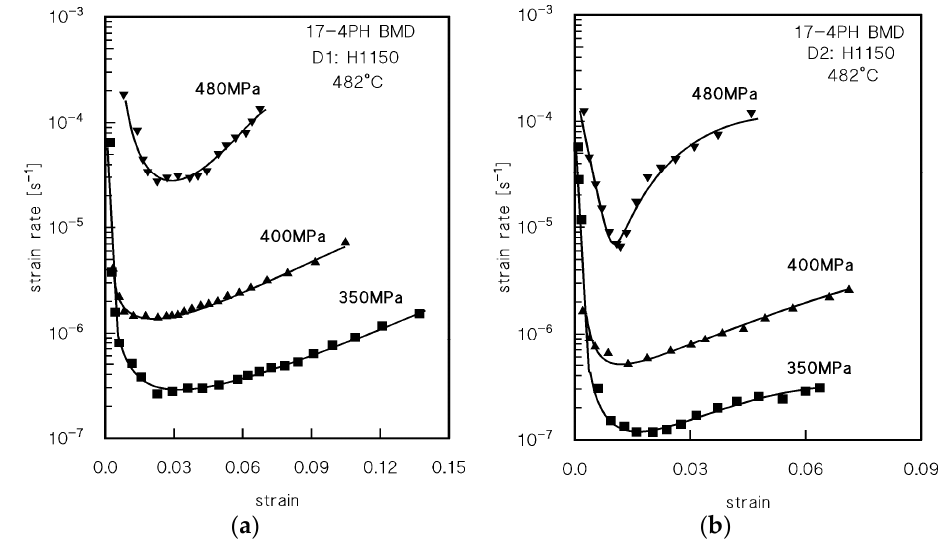
Figure 3. Creep curves (creep strain vs. creep strain rate) at 482 °C for: ( a ) D1 H1150; ( b ) D2 H1150.